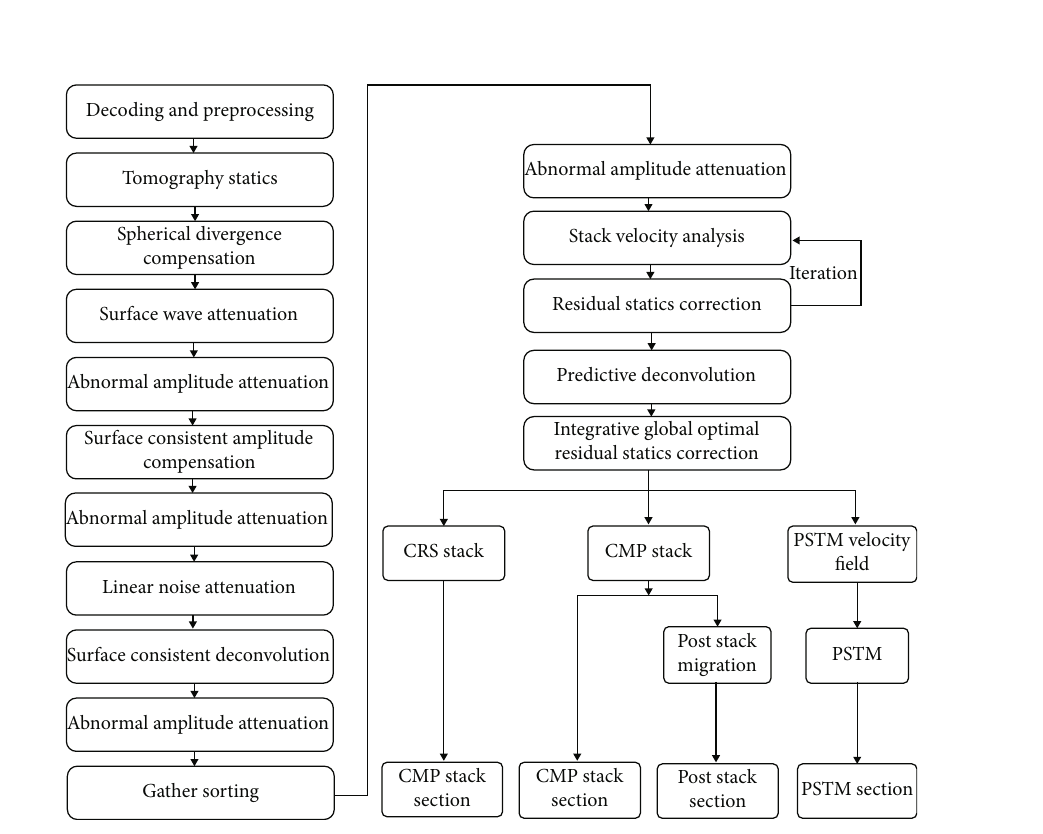
Figure 13: Seismic data processing work fl